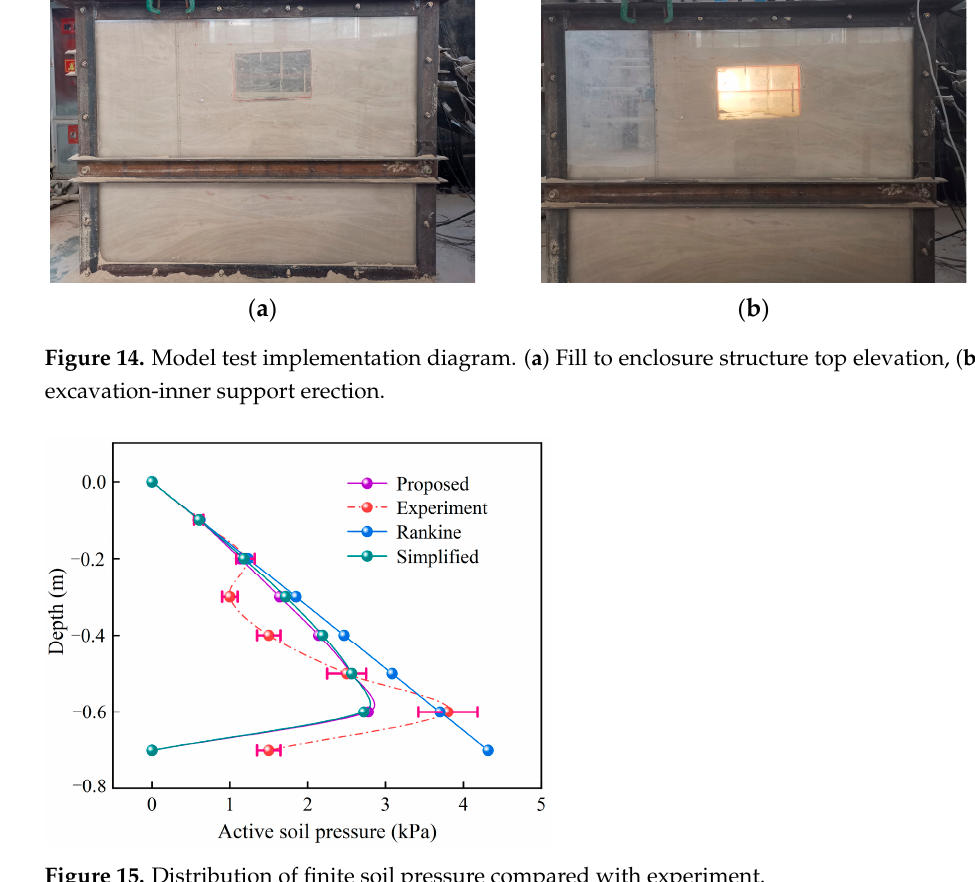
Figure 15. Distribution of finite soil pressure compared with experiment.